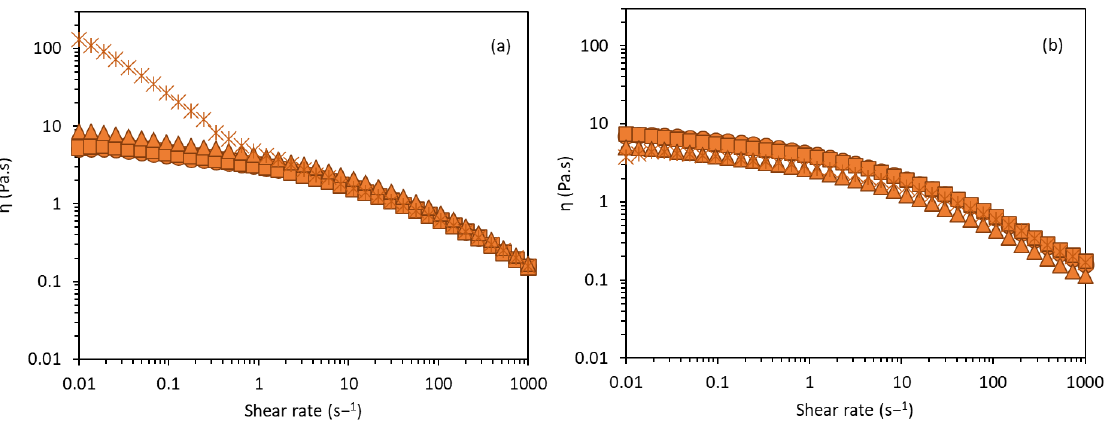
Figure 6. Flow curves for C1 ( a ) and C2 ( b ) formulations during the storage times: t = 1 (circles), t = 3 (squares), t = 7 (triangles), and t = 45 (asterisk).